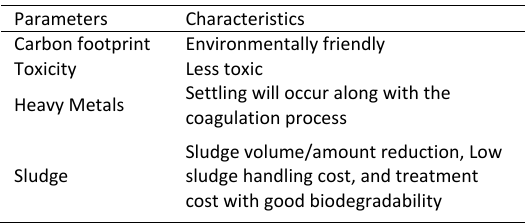
Table 3: Characteristics of natural coagulants